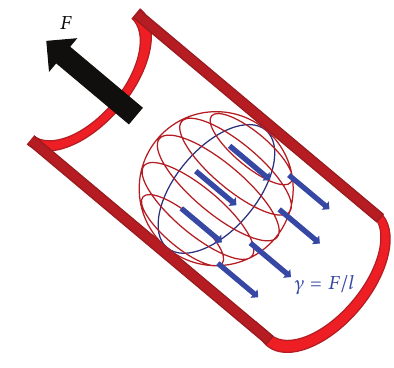
Figure 1: Surface tension (blue circle).